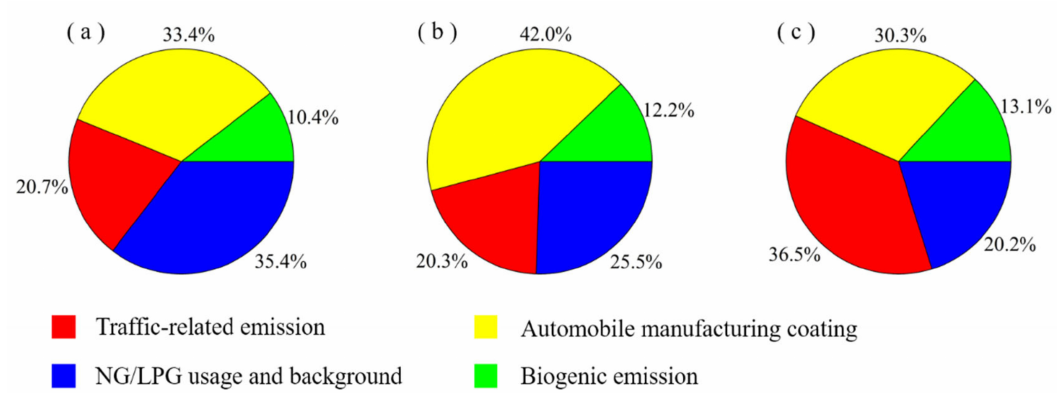
Figure 9. Average relative contribution of individual sources to ambient NMHCs mass concentrations during ( a ) the entire observation period, ( b ) two O 3 pollution days (September 16th–17th), and ( c ) two clean days (September